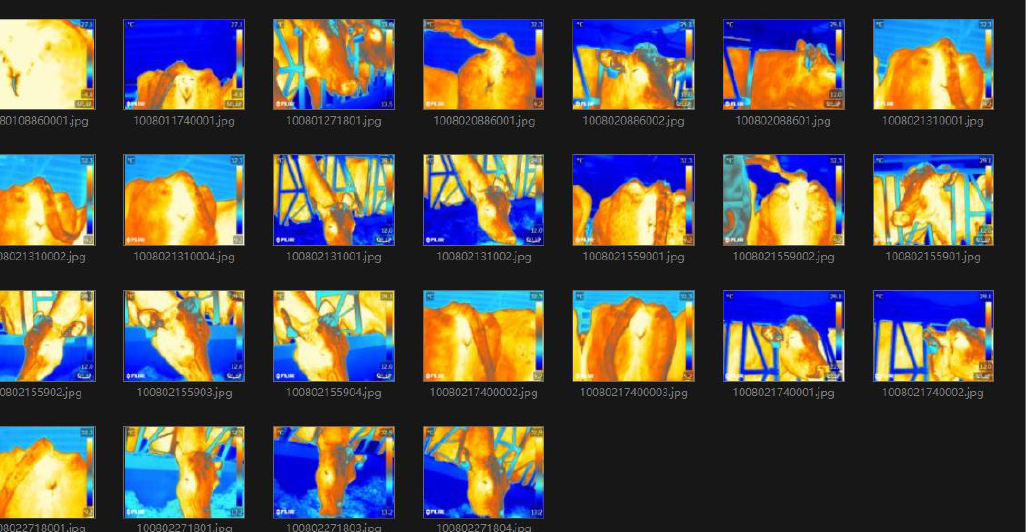
Figure 2. Shooting field of view .